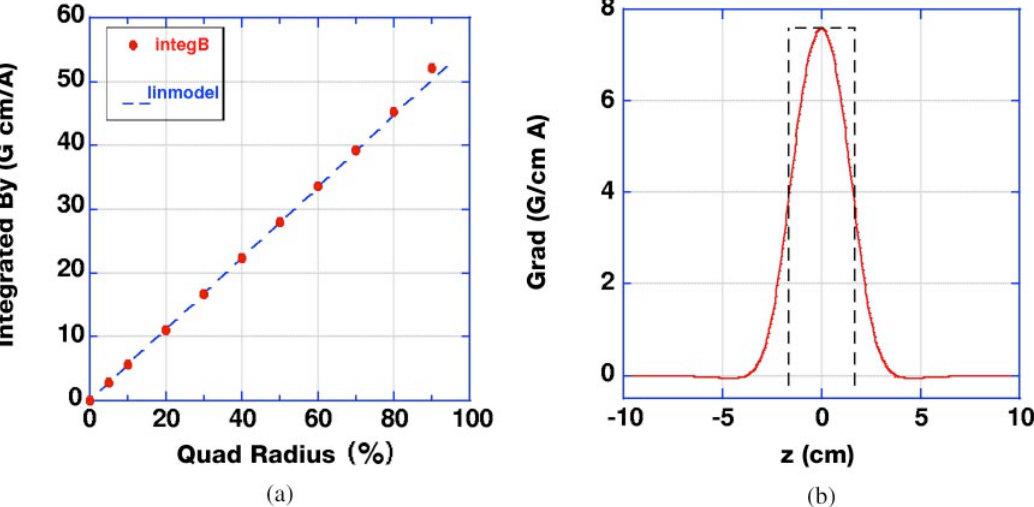
FIG. 2. (Color) PC Quadrupole: (a) radial variation of axially integrated field (per amp) at 0 – and (b) on-axis gradient (per amp). The dashed lines represent the hard-top